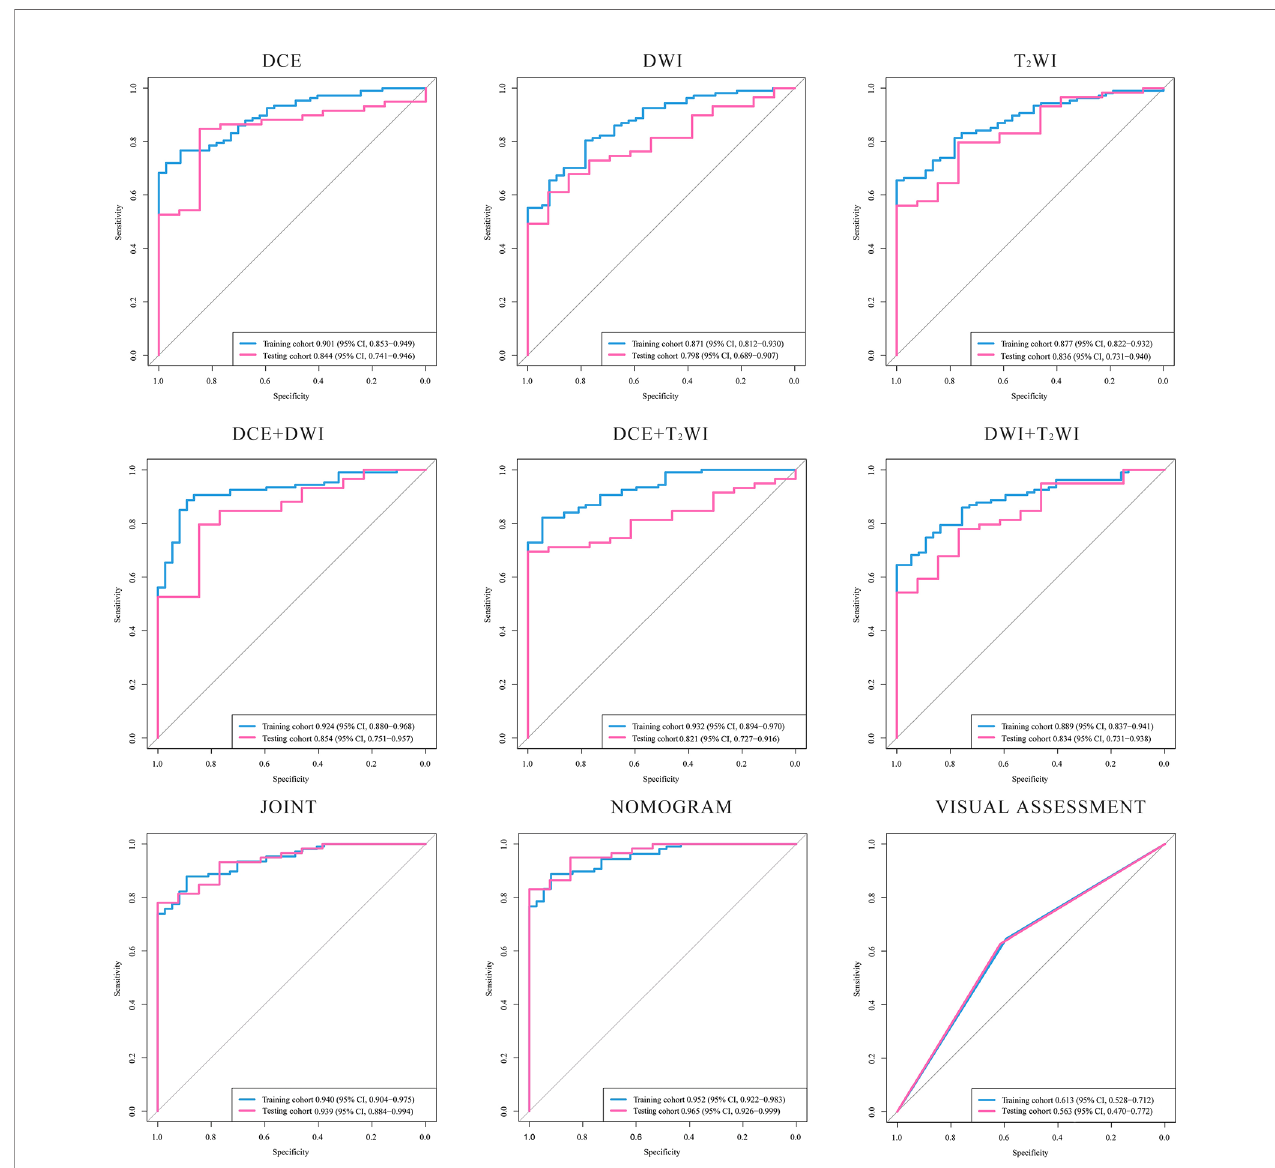
FIGURE 2 | ROC curves of the models. The ROC curves generated by models based on: DCE, DWI, T 2 WI, DCE+DWI. DCE+T 2 WI, DWI+T 2 WI, DCE+DWI+T 2 WI, nomogram combined age and the radiomic signature and the visual assessment of the radiologists. DCE, dynamic contrast enhanced imaging; DWI, diffusion weighted imaging; T 2 WI, 2 weighted